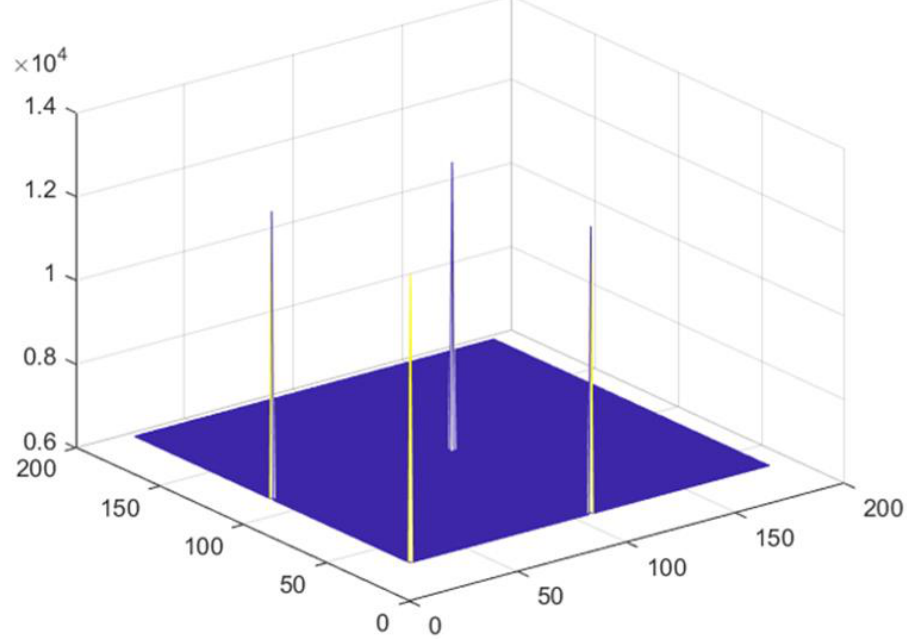
Figure 4. Response function of mosaic mask.